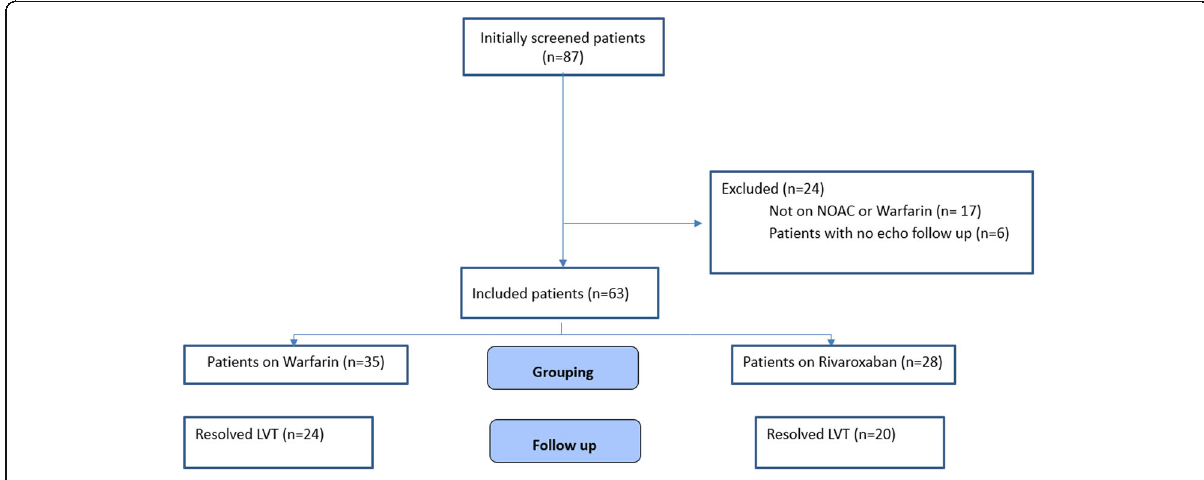
Fig. 1 Study flowchart (LVT, left ventricular